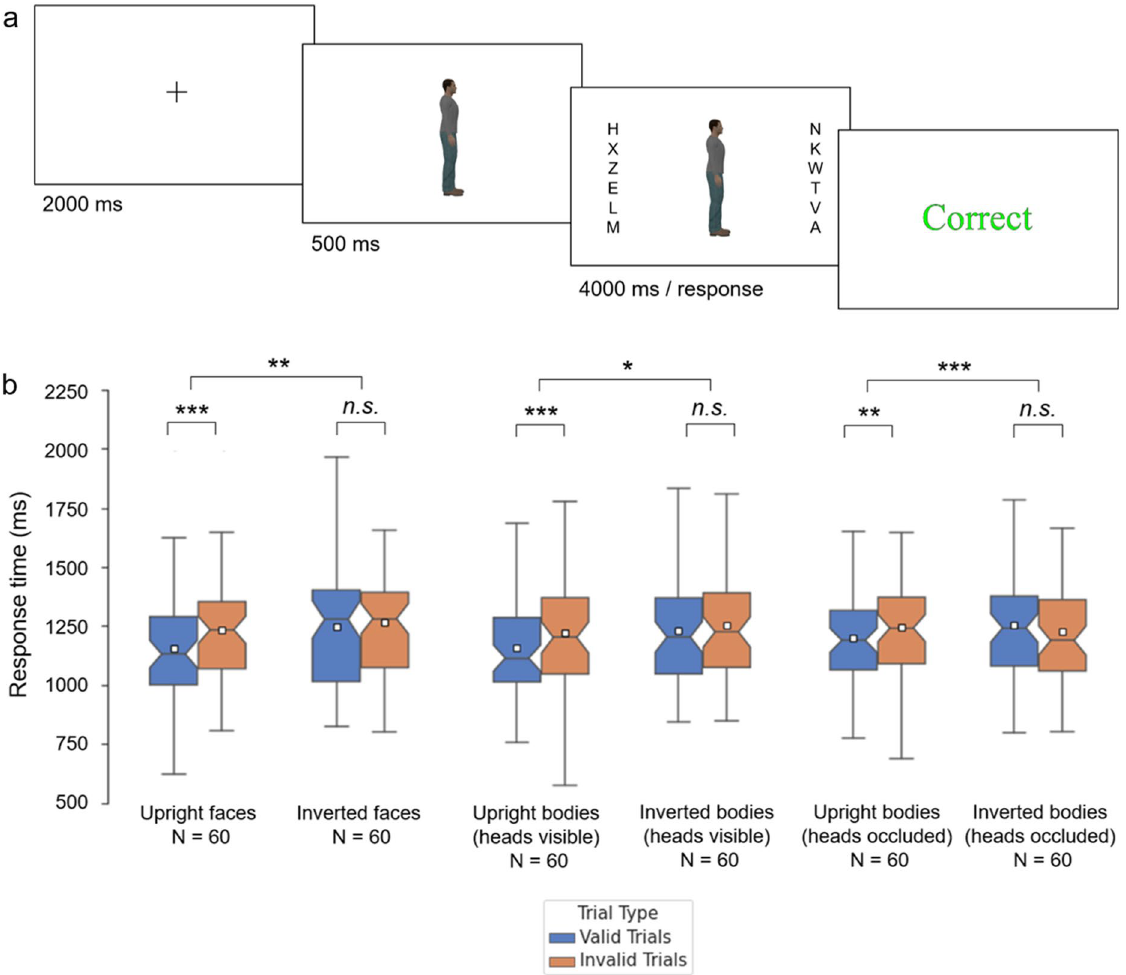
Figure 1. ( a ) Structure of a trial from the bodies (heads visible) experiment. The body image included in this schematic was not used as a stimulus image but is representative of the stimuli employed. This image was created by the authors for illustrative purposes. ( b ) Results from the cueing experiments conducted with faces and bodies. Boxes indicate inter-quartile range. Notches indicate confidence interval of the median. Whiskers indicate 1.5 * interquartile range. White squares denote the mean. *** denotes significance at p < .001. ** denotes significance at p < .025. * denotes significance at p <